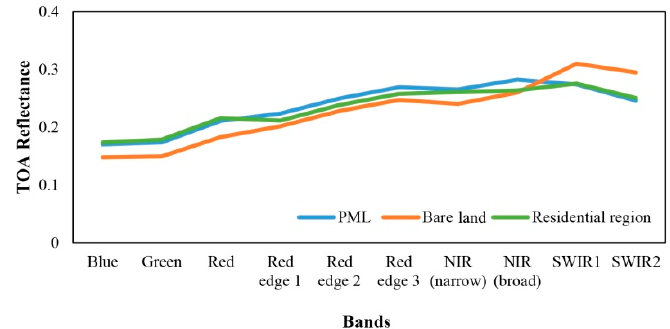
Figure 4. Typical spectral profile of PML, bare land, and residential region in the plastic-film-covered stage. The figure was generated using the 1–15 April Sentinel-2 data and the corresponding training samples collected in April (Table 1). Blue, Green, Red, Red-edge 1, Red-edge 2, Red-edge 3, NIR (narrow), NIR (broad), SWIR 1, and SWIR 2 bands are B2, B3, B4, B5, B6, B7, B8A, B8, B11, and B12 bands of Sentinel-2 data.